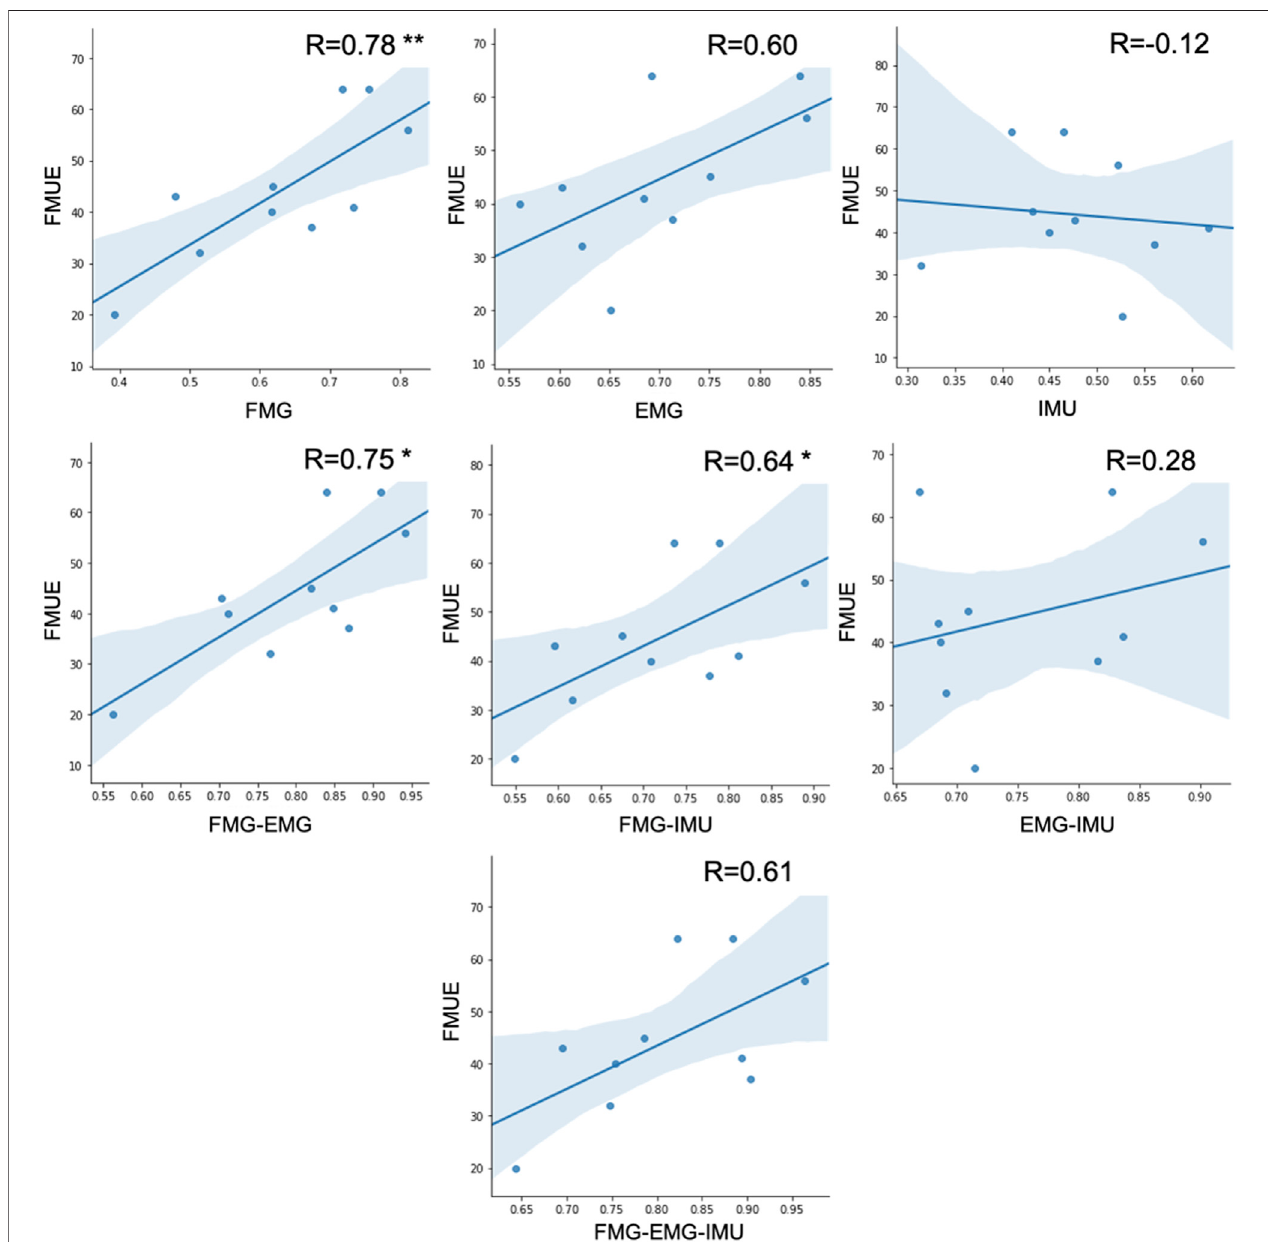
FIGURE 9 | The correlation between FMUE scores and different sensing modality-based classi fi cation accuracies for all subjects (* represents p < 0.05, ** represents p < 0.01).